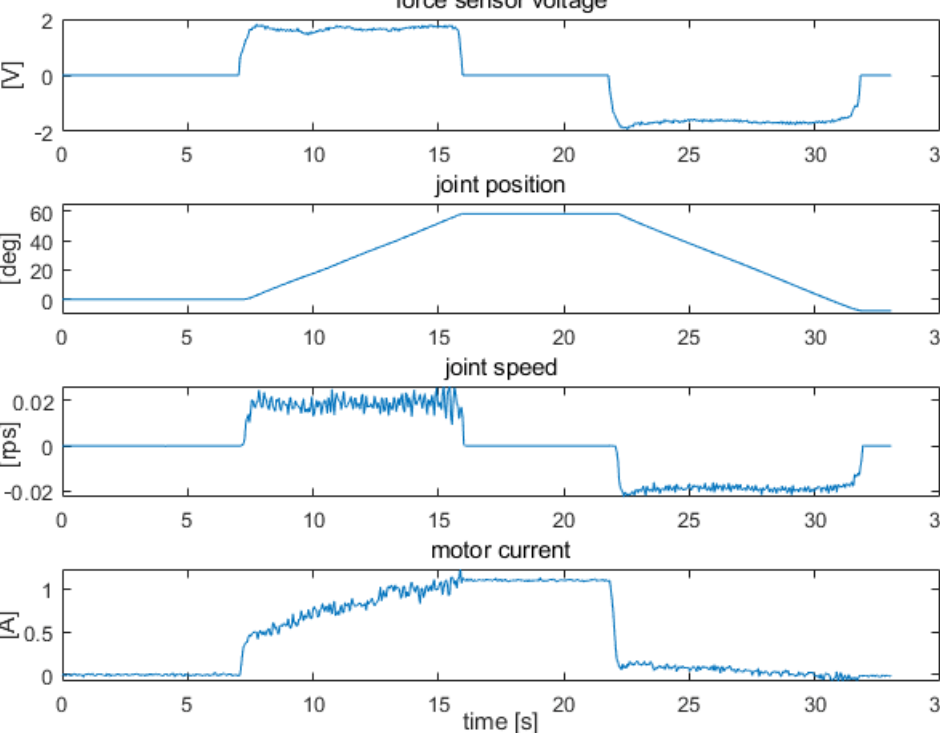
Figure 10. Signal waveforms from force, position, speed, and supply current sensors for elbow joint drive under light force on the sensors.